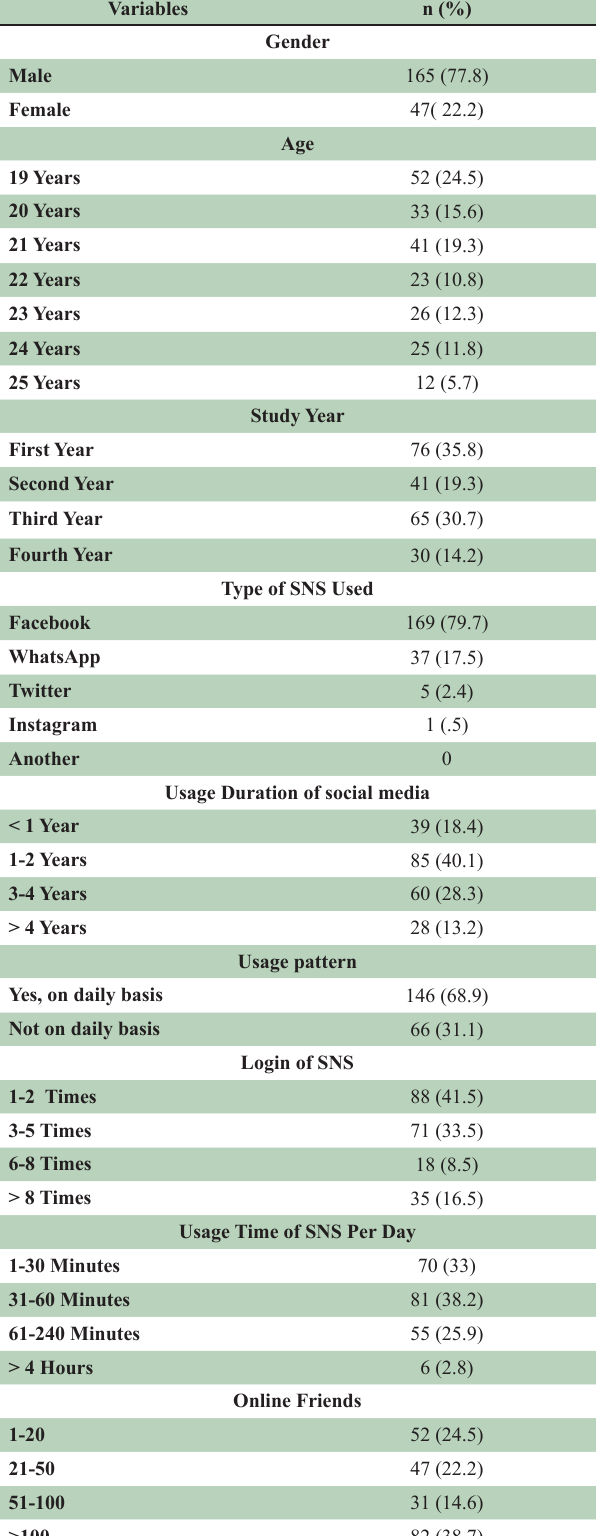
Table-I: Demographics and scale statistics of social networking site users